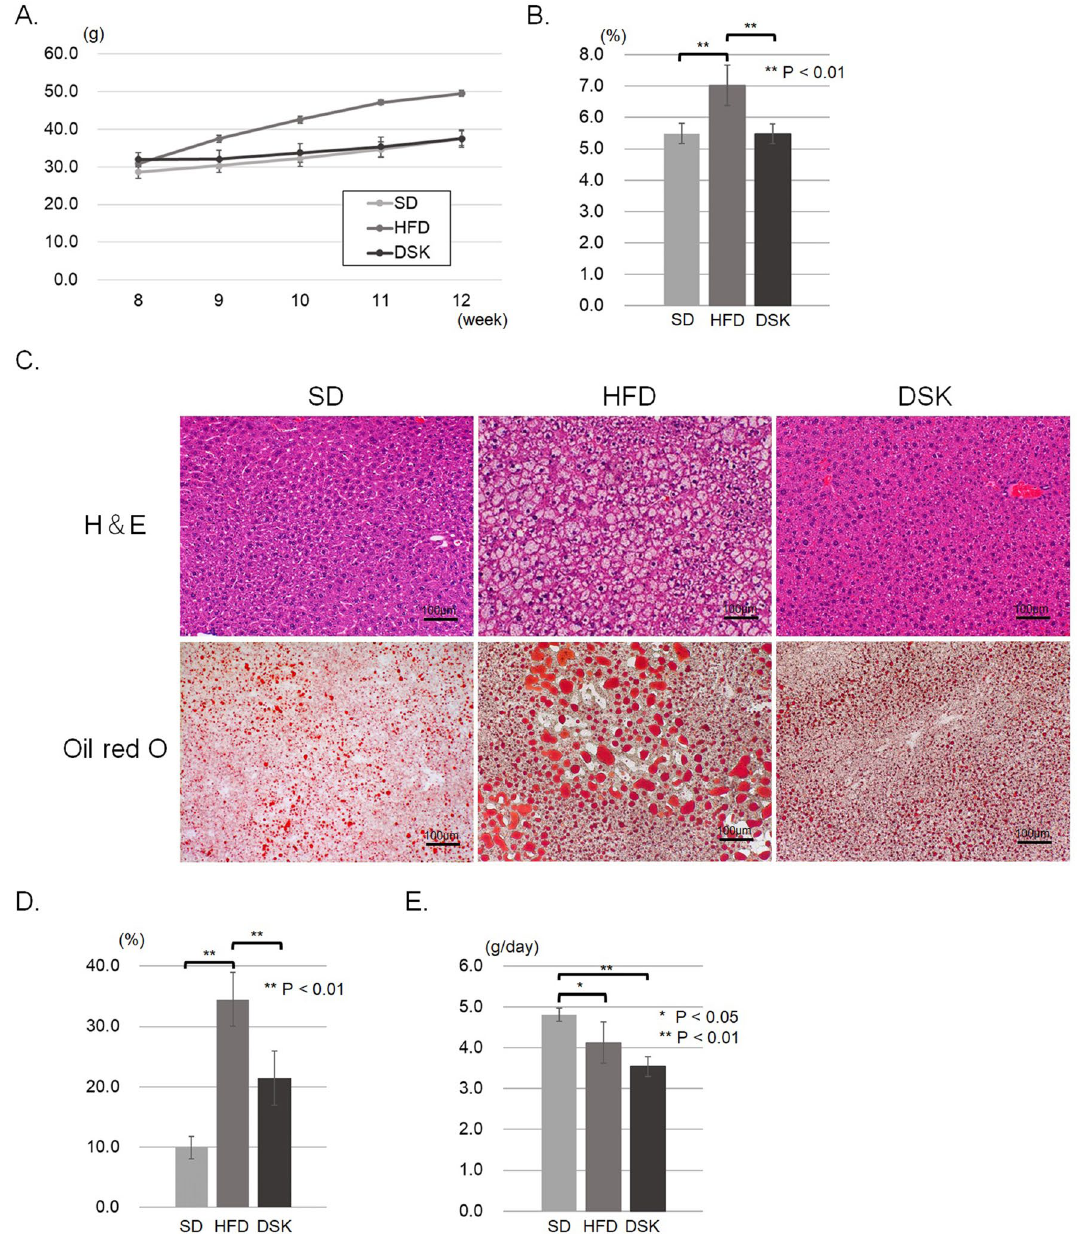
Figure 1. Effect of daisaikoto on fat accumulation in MC4R-KO mice with a high-fat diet. Changes in body weight during 4 weeks of every week ( A , n = 4, P < 0.01). The liver-to-body weight ratio in the HFD group was significantly higher than in the other two groups ( B , P < 0.01). H&E and oil red O staining indicated that fat deposition in the HFD group was significantly higher than that in the other two groups with a significant difference ( C,D , P < 0.01). Meanwhile, no statistically significant differences were found in the dietary intake between the HFD and DSK groups ( E ). MC4R-KO melanocortin 4 receptor gene knock out, H&E hematoxylin and